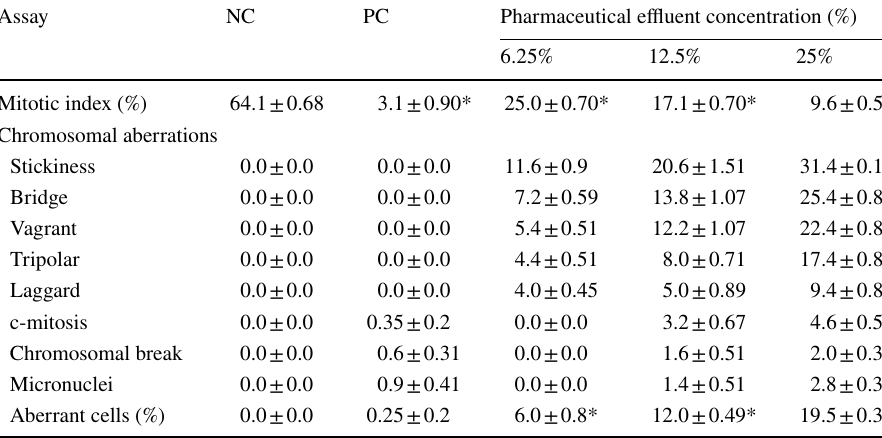
Values are mean ± SE ( n = 5) control (tap water), PC positive control (C=C) group, and peak 1233–1075 cm −1 shows the in- plane deformed peak of benzene (Ermakova et al. 2015).